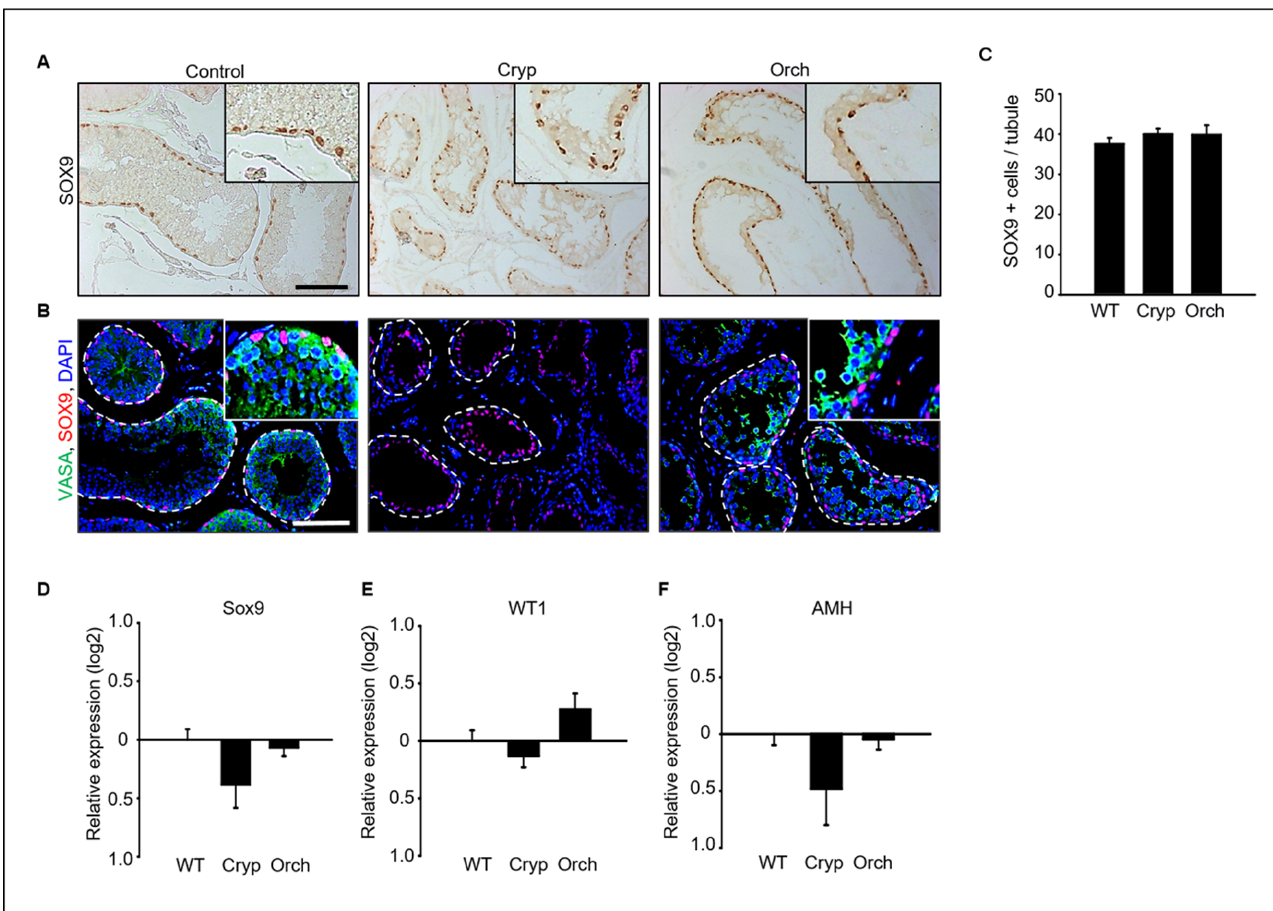
Figure 3. ( A ) SOX9, a Sertoli cell marker protein, was detected in wild-type, cryptorchid, and orchiopexied dog testes by DAB staining. SOX9-positive cells were found in all samples. ( B ) Both SOX9 and VASA, a germ cell marker, were detected in all three groups. VASA- and SOX9-positive cells were not exactly overlapped in wild-type testes; VASA-positive cells were not observed in cryptorchid testes. Scale bars = 50 μ m; n = 3, two pairs of testes. ( C ) The average number of SOX9-positive Sertoli cells in the tubules was counted based on immunostaining from three different samples. At least 40 tubules were scored for each slide, for a total of 3 biological replicates. Data are presented as the mean ± standard deviation; no significant difference was found. Status of Sertoli cells in wild-type, cryptorchid, and orchiopexied dog testes. The expression levels of ( D ) SOX9 , ( E ) Wt1 , and ( F ) AMH genes were detected by qPCR.